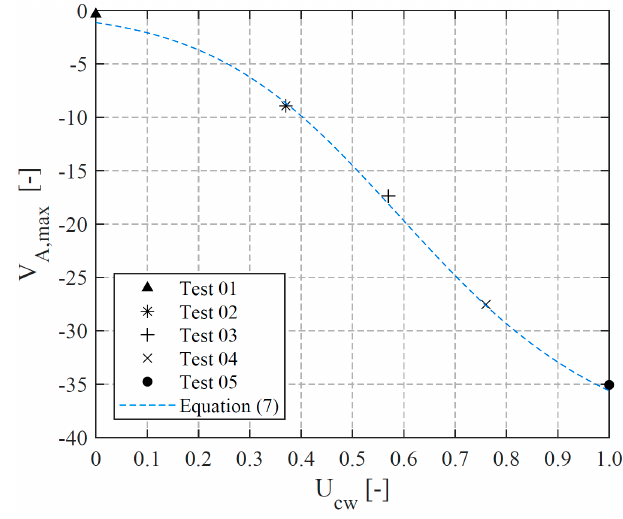
Figure 7. Maximum cumulative erosion volume V A , max (see Equation (4)) of test 1–5, depicted over the wave current velocity ratio U cw (see Equation (2)) in comparison to Equation (7) (see also Figure 6b; ~1.25 A).